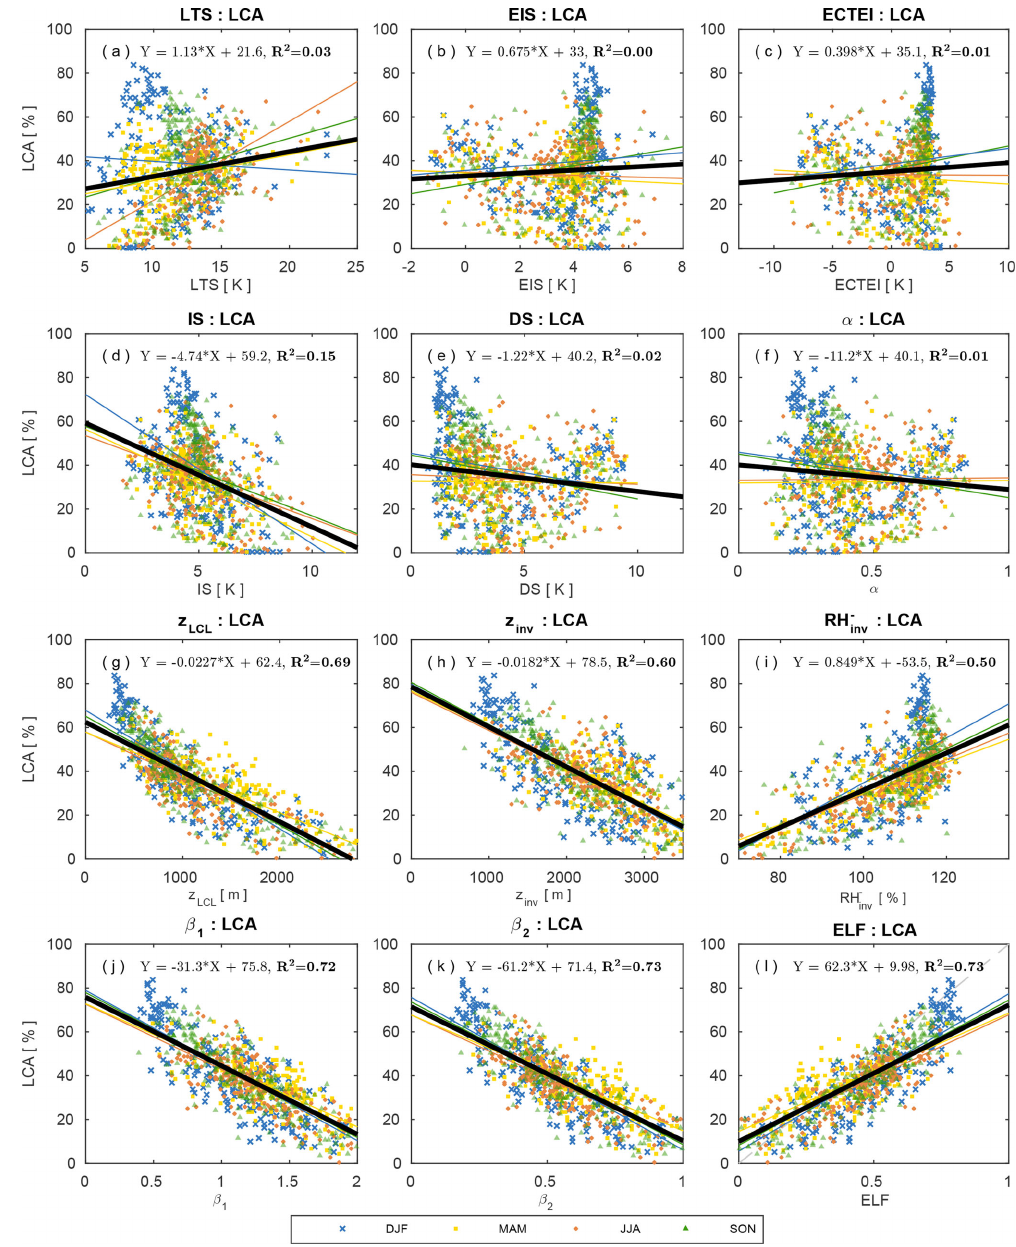
Figure 6. The same as Fig. 5 but over